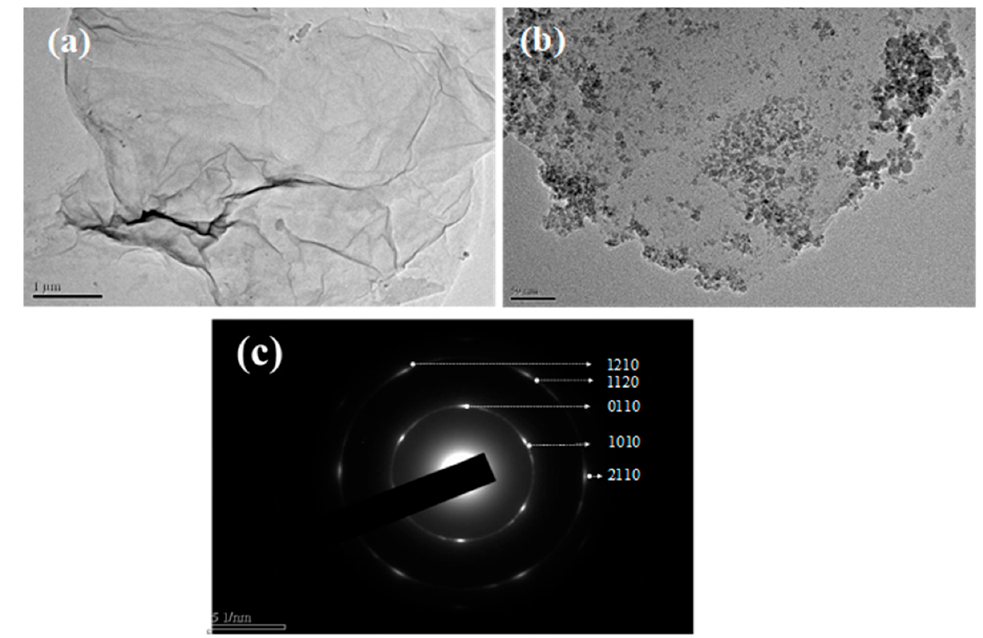
Figure 2. TEM image of ( a ) graphene oxide (GO) (scale bar: 1 mm); ( b ) MRGO (scale bar: 50 nm); ( c ) selected area electron diffraction (SAED) pattern of GO.